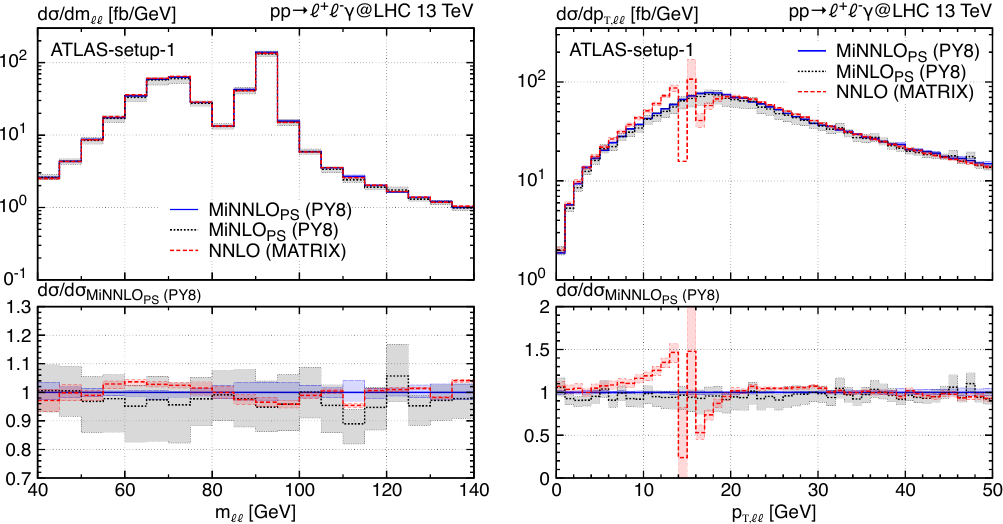
Figure 7. Distribution in the invariant mass (left plot) and in the transverse momentum (right plot) of the lepton pair for MiNNLO (blue, solid line), MiNLO 0 (black, dotted line) and NNLO PS (red, dashed